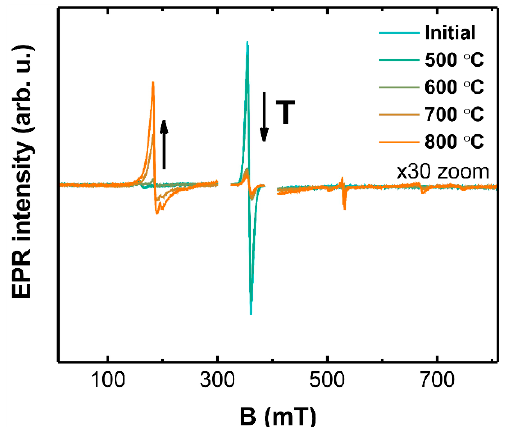
Figure 9. EPR spectra of 1% Cr LaOCl samples after annealing at different temperatures in reducing